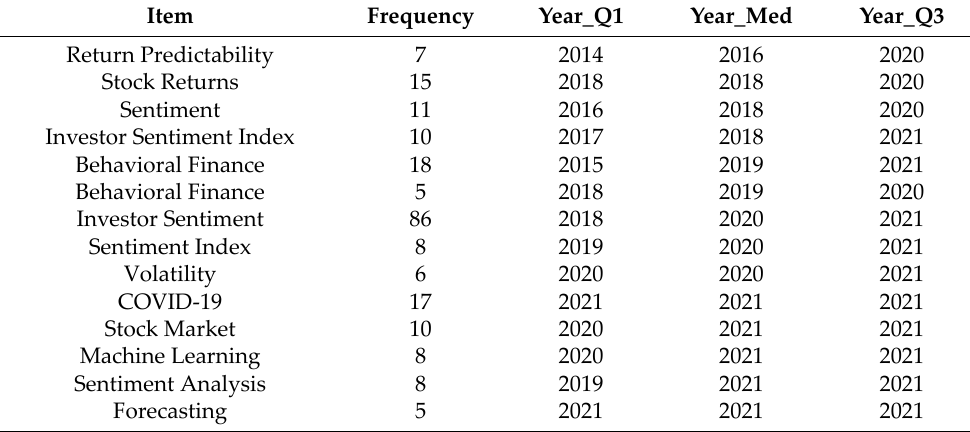
Table A5. Trending